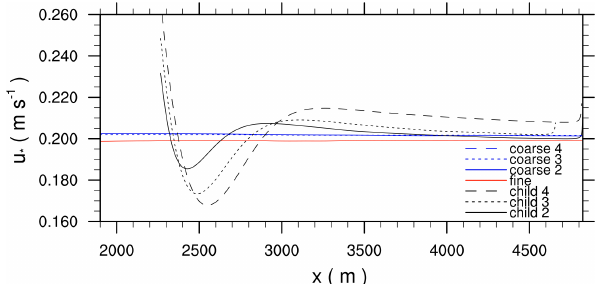
Figure 9. Instantaneous horizontal cross section of the u component in ms − 1 at z = 40m. The black box indicates the location of the child domain. The solid white lines indicate the x locations where the profiles shown in Fig. 11 are averaged over the y direction.